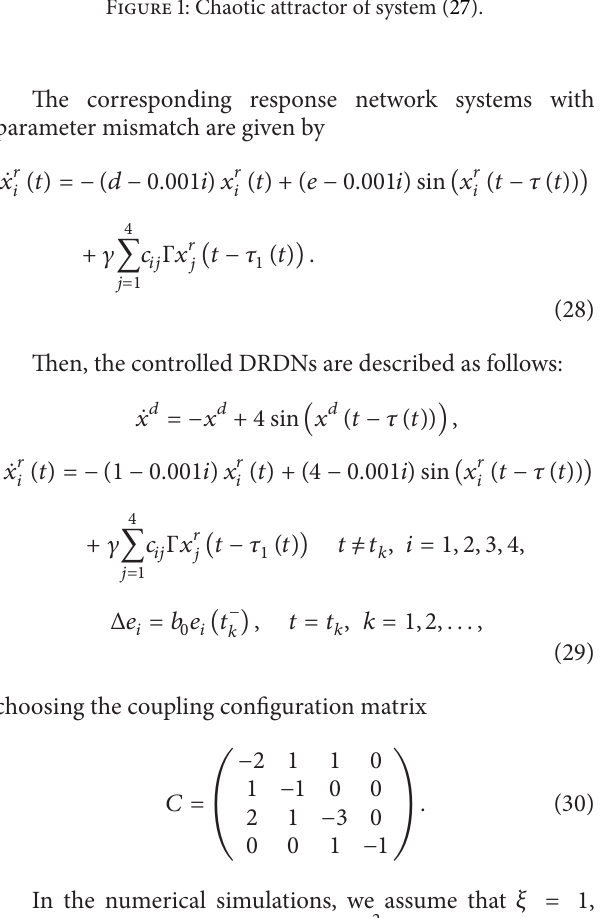
Figure 1: Chaotic attractor of system (27).